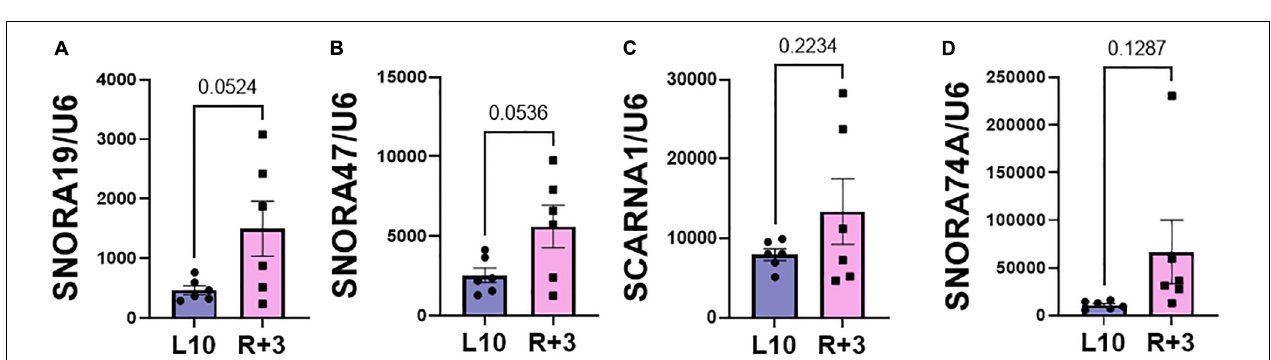
FIGURE 1 | Small RNA sequencing of EV-derived RNA content. (A) Heat map of snoRNAs differentially expressed (fold change > 2 and FDR < 0.05) in the EVs derived from peripheral blood (PB) plasma collected 10 days before the launch (L-10) and 3 days after landing (R + 3) from five astronauts who flew Shuttle missions between 1998 and 2001 ( n = 5 astronauts per group). (B) Validation of differentially expressed SNORA74A by RT-qPCR, normalized to U6 snRNA, n = 3 astronauts/group. Data are presented as mean ± SEM, ∗∗ p < 0.01 vs. L-10 (two-sided unpaired students t -test).